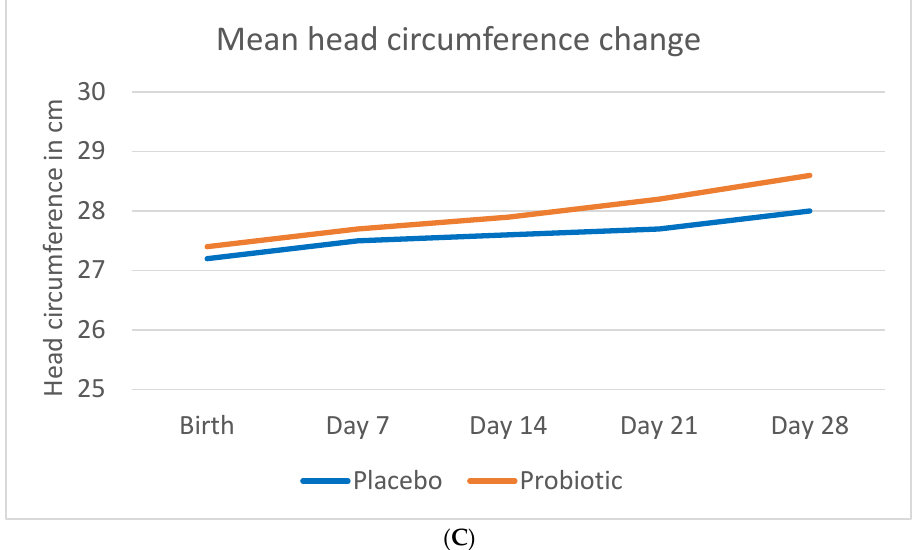
Figure 1. Change in anthropometric measurements during the study period. ( A ) Mean crude change in weight ( B ) Mean crude change in length ( C ) Mean crude change in head circumference. Table 4 indicates the crude weight, length, and head circumference changes over time and at the different time points. The change in weight over time was statistically significant in probiotic group, from day 21 onwards. The change in length was statistically significant only at day 28. There was no statistically significant change in the head circumference. Table 4. Change in the crude anthropometric measurements of the neonates over the trial period. Estimated Difference 95% CI p ‐ Value Estimated Difference 95% CI Weight Weight On average over